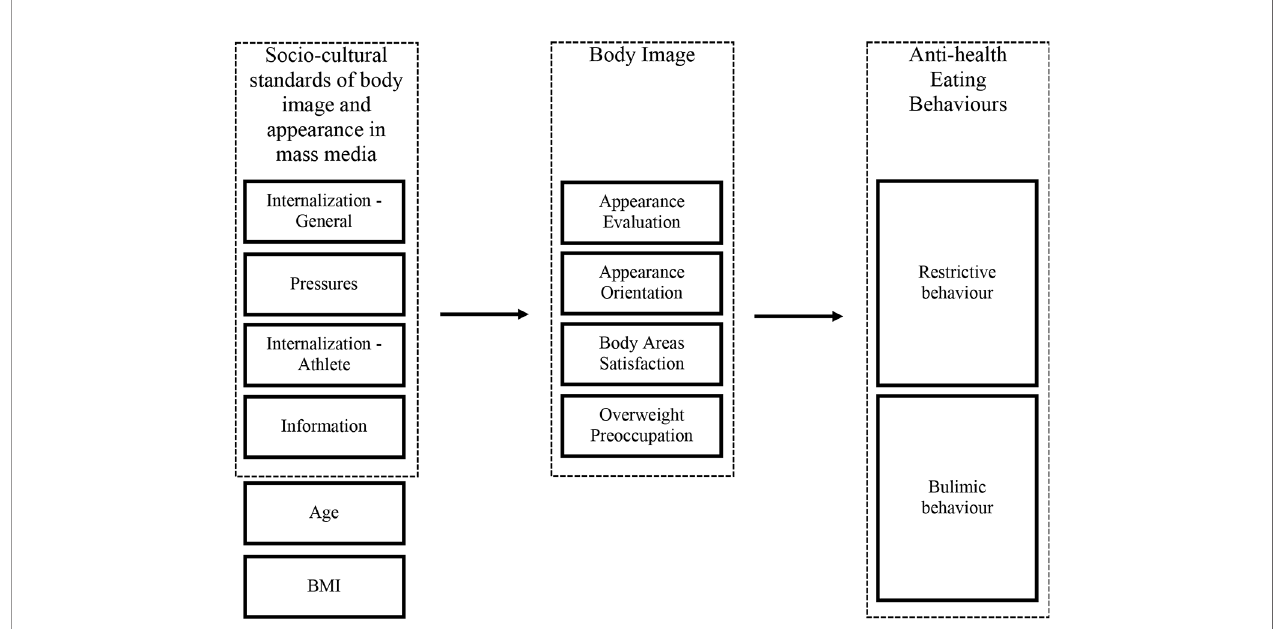
FIGURE 1 | Theoretical model of variable